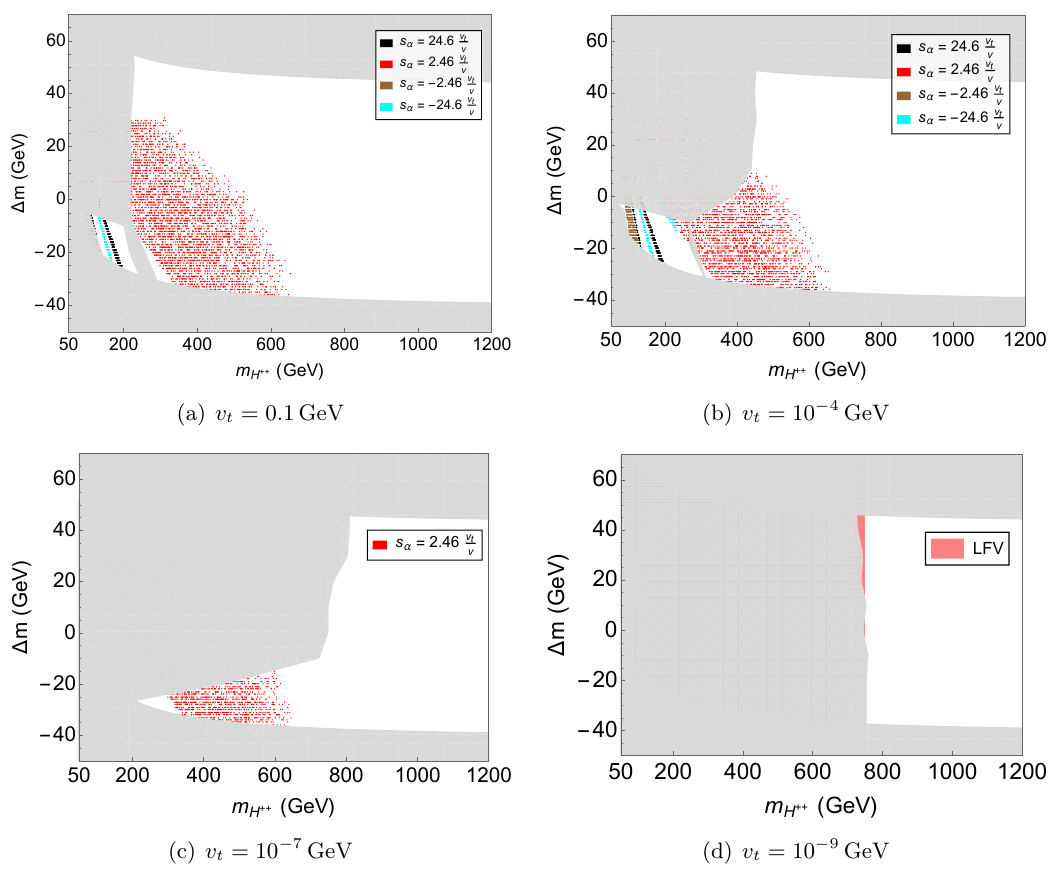
Figure 8 . The combination of allowed regions from the Higgs data, shown from figure 1, and the exclusion regions of colliders, Higgs invisible searches and EWPT, shown in figure 5. In the figure, 4 GeV, 10 7 GeV and 10 9 GeV. Additionally for each value of v we take v = 0 . 1 GeV, 10 − − − t = 2 . 46 v/v and 24 . 6 v/v for the allowed regions. The gray shaded take the benchmark cases s α t t ± ± region is the combination of exclusion regions of colliders, Higgs invisible searches and